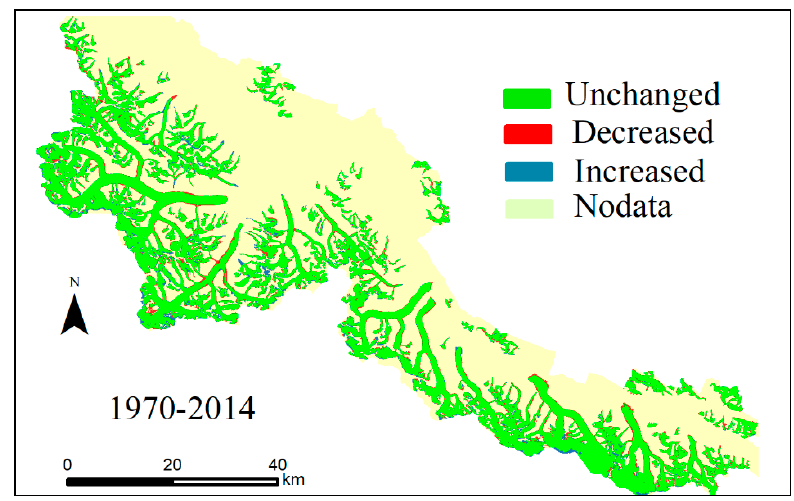
Figure 9. Spatial patterns of glacier are changes during 1970–2014.